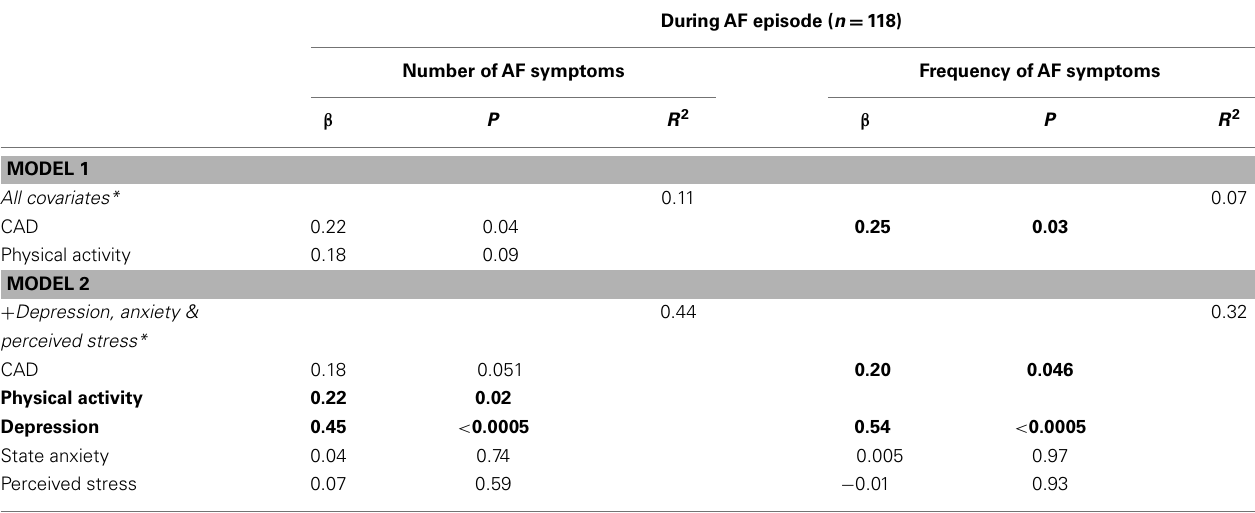
Table 5 | Multivariable regression analyses on the effects of emotional distress on the number and severity of reportedAF symptoms during the AF